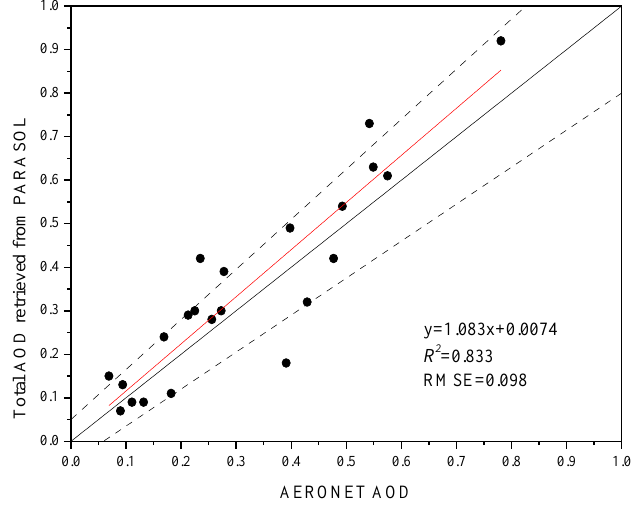
Figure 4. Comparison of AOD (550 nm) retrieved from PARASOL against AERONET sunphotometer measurements. The dash lines correspond to ±0.05 ± 0.15 τ AERONET error of total AOD.